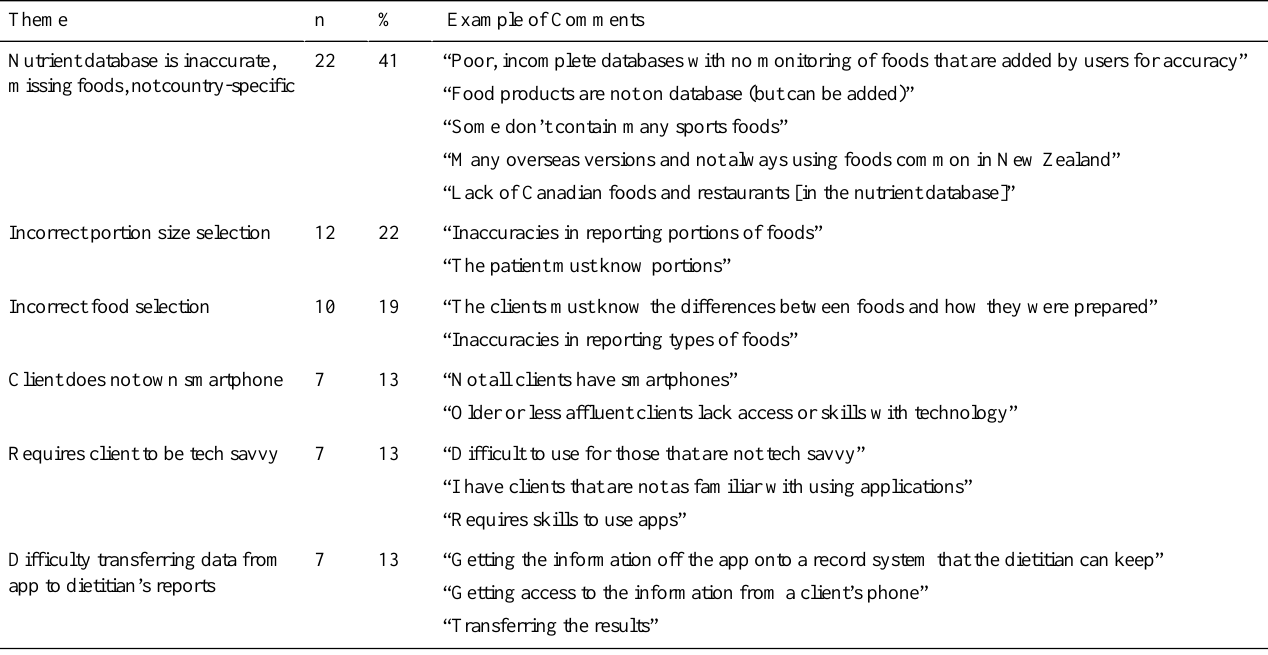
Table 2. “What are the limitations of using smartphone diet apps?” (N=54) a .